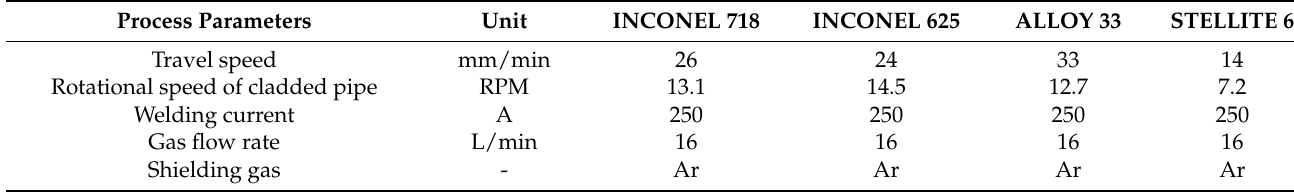
Table 2. The parameters of TIG remelting cladded coatings